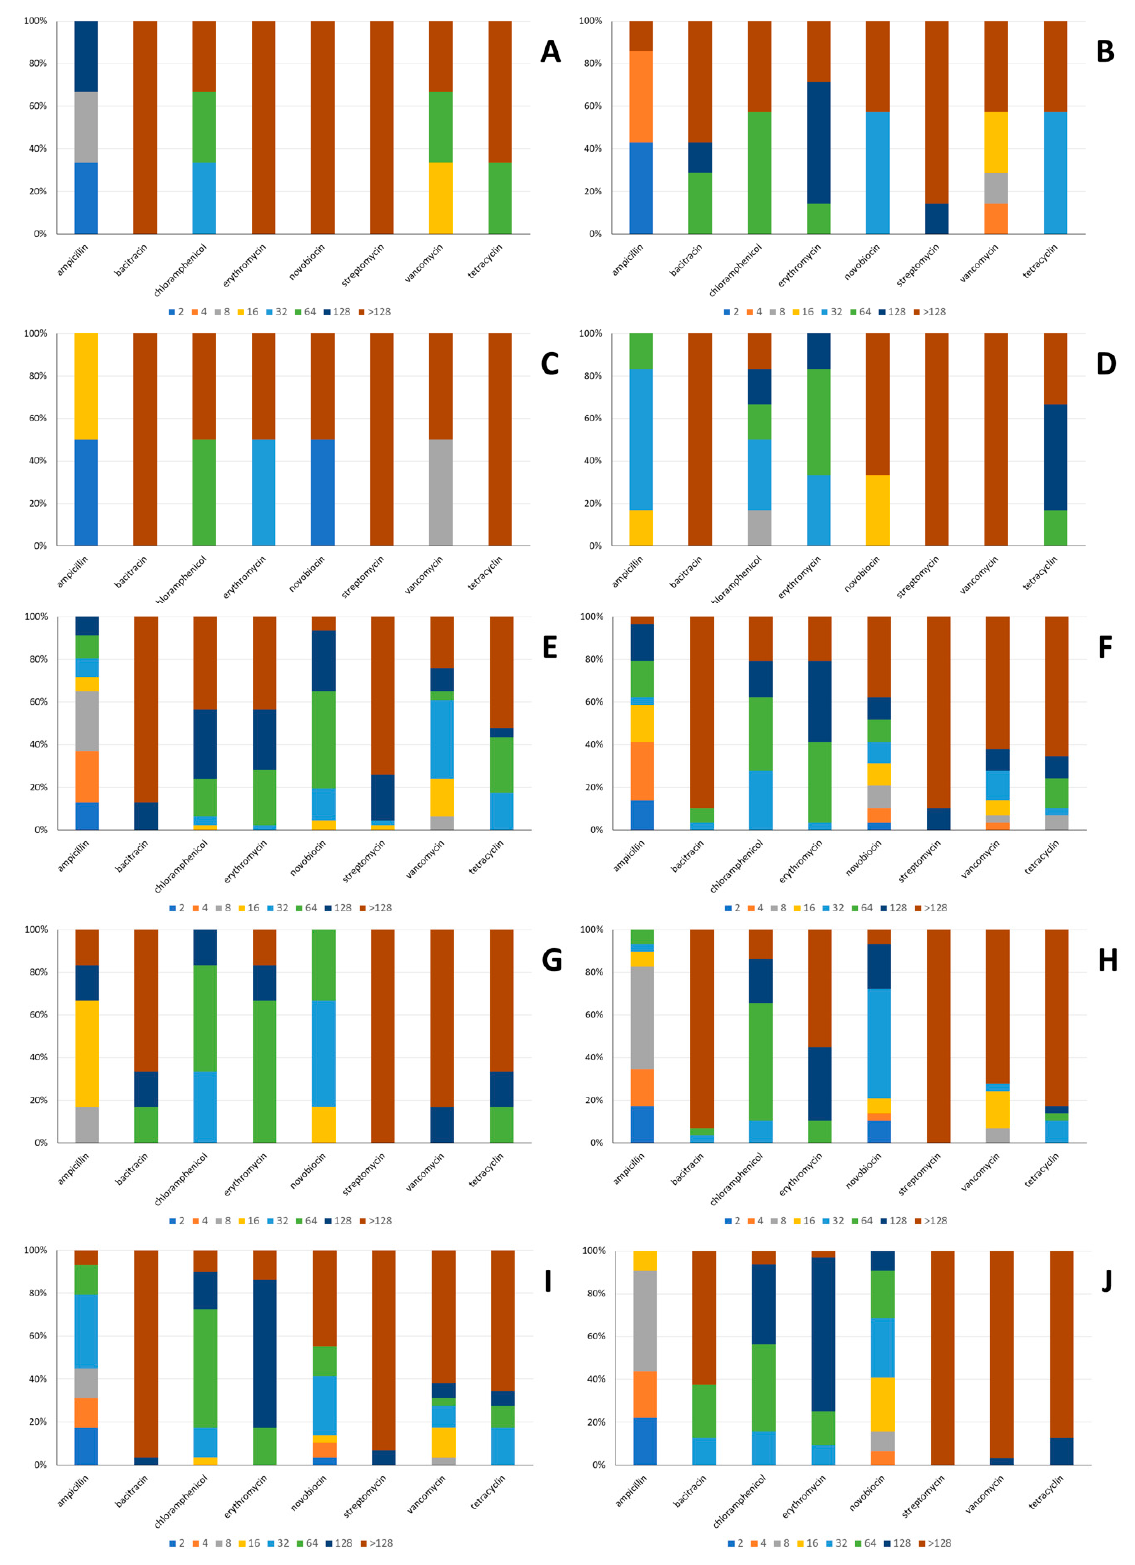
Figure 1. Antibiotic susceptibility of E. faecalis ( A ), Lc. lactis ( B ), Lp. pentosus ( C ), Lt. curvatus ( D ), E. faecium ( E ), P. pentosaceus ( F ), Ln. mesenteroides ( G ), Lp. plantarum ( H ), Lv. brevis ( I ), and W. paramesenteroides ( J ). The concentration of each antibiotic that was necessary to inhibit growth of the strains of each species included in the present study (in mg/mL), indicated in colors.